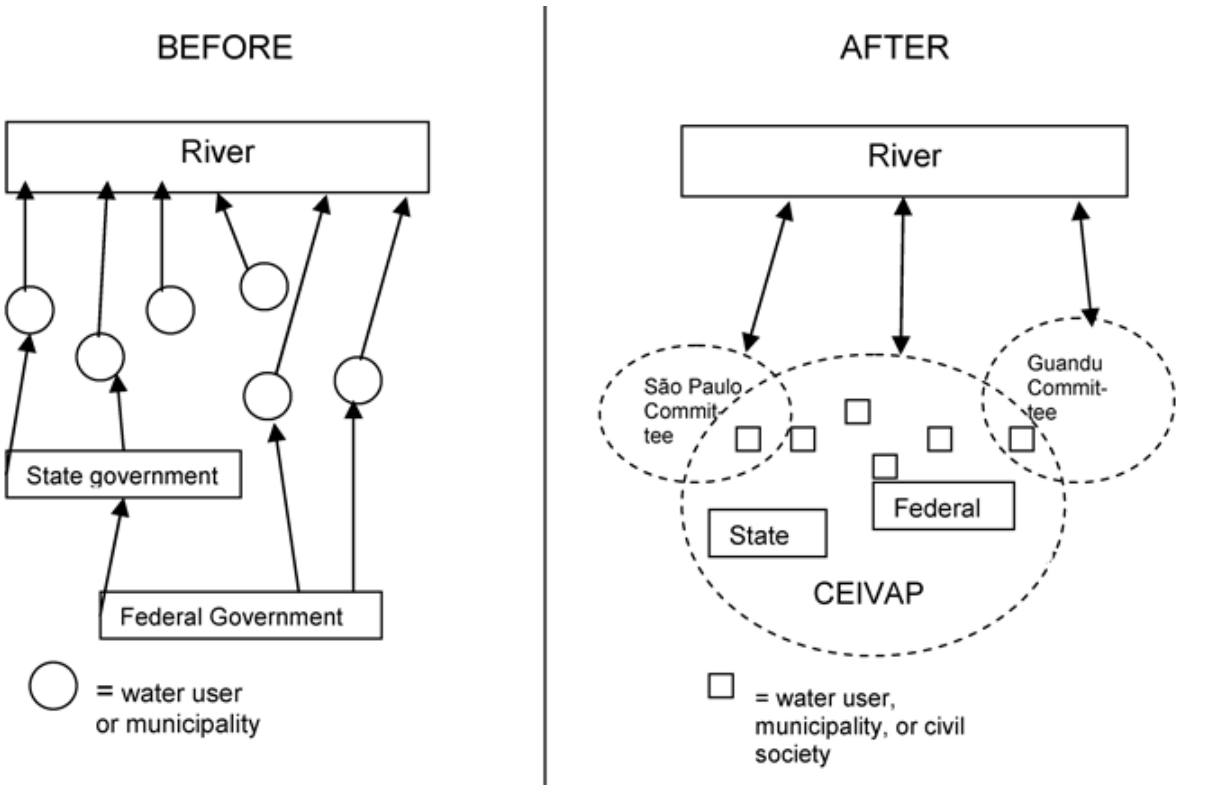
Fig. 4. Conceptual decision-making diagram. Decision making by water users on the Paraíba do Sul before and after the new water policy. Arrows represent direction of water-use decision making and coordinated information flow. Ovals in the “After” diagram show committees and are dashed to show that they are open to outside interaction and participation. Notice the committee and membership overlap, streamlined water-use decisions, and enhanced flow of information from the river to committees in the “After” diagram compared with the relatively uni-directional and isolated decision making of the first